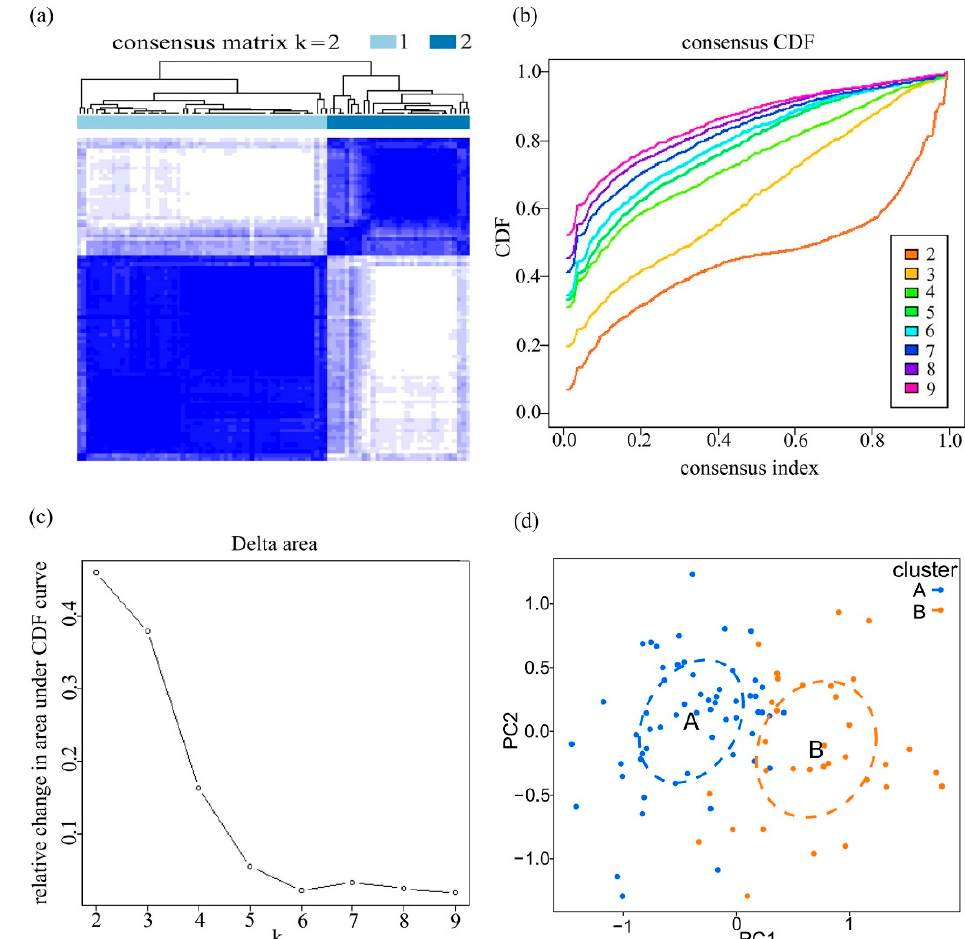
Figure 5. Consensus clustering of 21 adipocytokine pathway-related genes. ( a ) 91 epilepsy samples were grouped into two clusters according to the consensus clustering matrix (k = 2). ( b ) Cumulative distribution function (CDF) curve when k ranges from 2 to 9. ( c ) Changes in area under CDF curve when k ranges from 2 to 9. ( d ) Principal component analysis shows a good differentiation between the two clusters. The blue and orange dots represent clusters A and B, respectively.